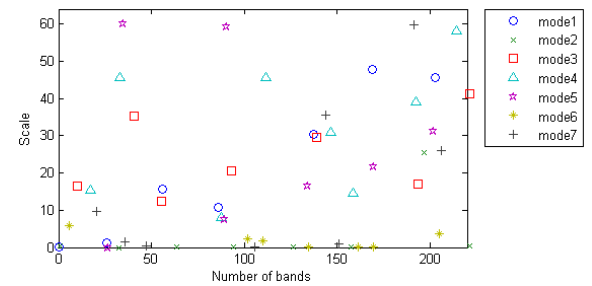
Figure 5. Locations of learned wavelons on time-frequency